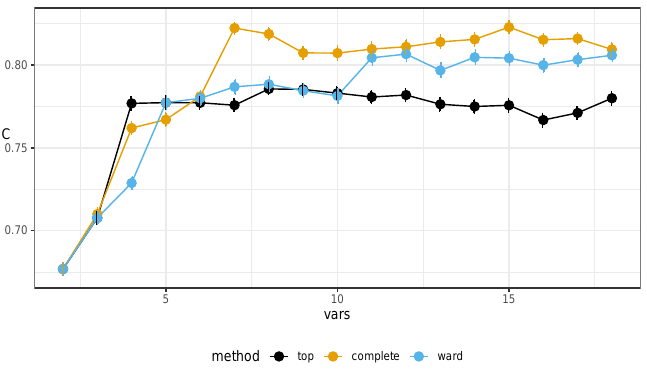
Figure 6. Plots of the area under the receiver operating characteristic curve (AUC) of Random Forest classifiers, using markers selected by the top- n approach and two variants of hierarchical clustering inside our proposed protocol (complete linkage and Ward’s criterion). These results were obtained in 100 runs of resampling of the standard protocol, as described in the paper body. Error bars denote the standard error. The complete linkage variant again exhibits the desired behavior, achieving the best results earliest, with the plateau starting at